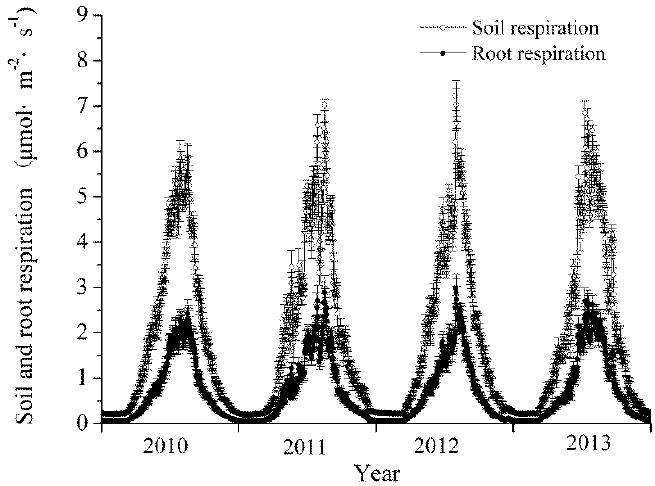
Figure 1. Daily mean soil and root respiration in the L. principis-rupprechtii forest during 2010–2013. Error bars are based on 0.5 h soil temperatures as experimental unit ( n = 48). Table 1. Parameters in the temperature response function (Equation (4)) for soil respiration (R S ,